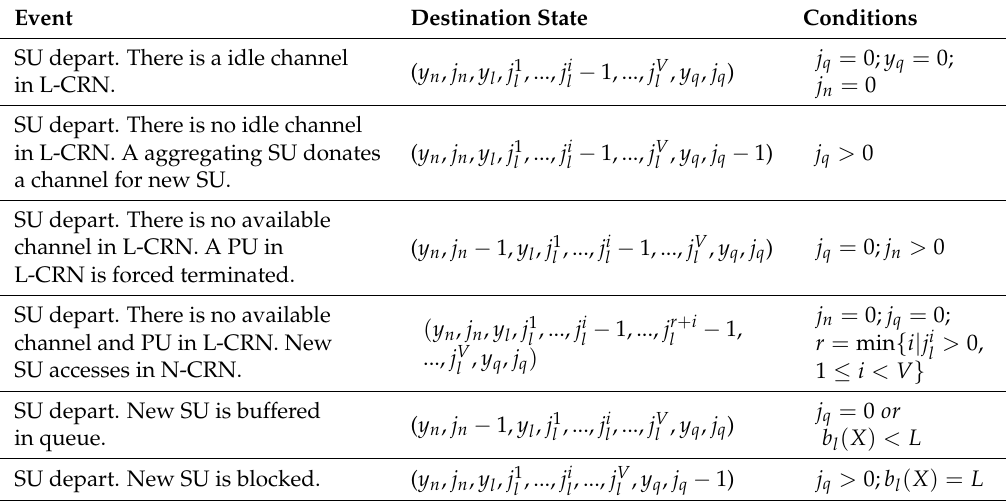
Table 4. Transitions of DFSL when a SU